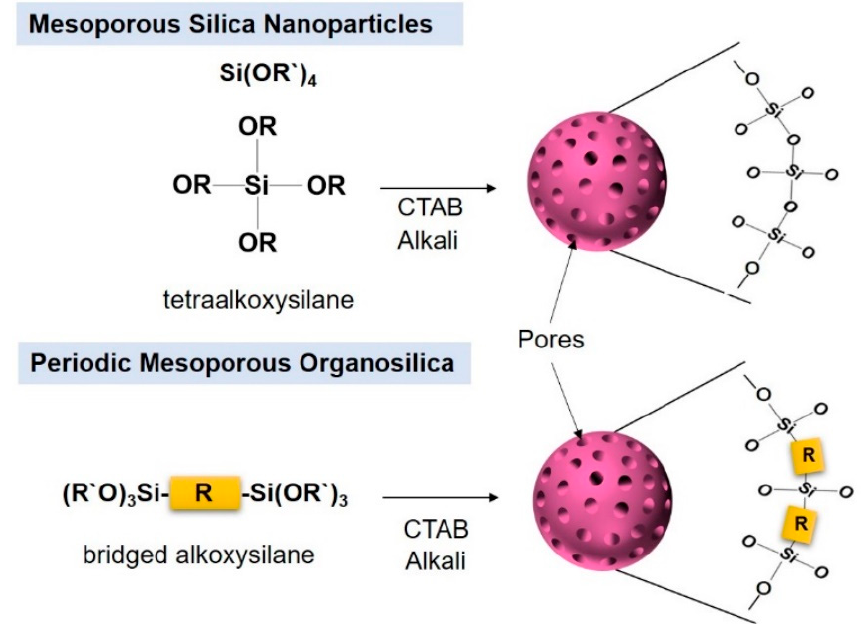
Figure 1. Schematic representation of mesoporous silica nanoparticles (MSNs) and periodic mesoporous organosilica nanoparticles (PMOs) with precursors.